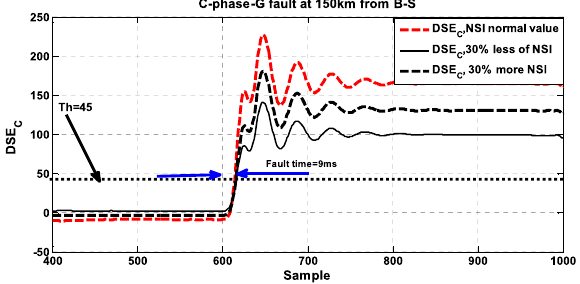
Fig. 6 Fault in C phase-G, 150 km from S-bus (B-S) , SI=Normal SI value, 30% less and 30% more of NSI